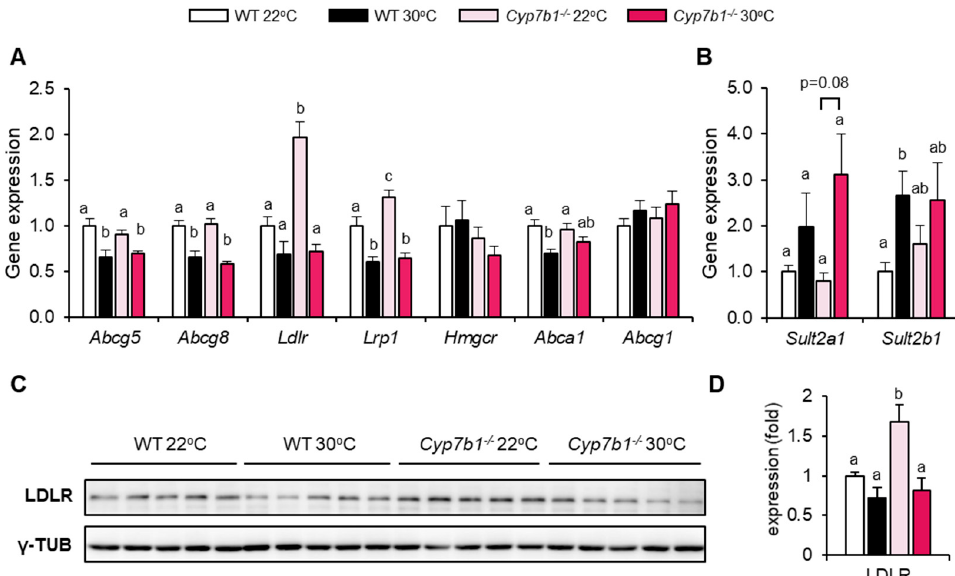
Figure 7. CYP7B1-deficiency affects expression of lipoprotein receptors but not other cholesterol-handling genes. Cyp7b1 − / − and WT littermates were housed at 22 °C or 30 °C and fed a CD-HFD for 8 months. ( A , B ) Relative hepatic expression of ( A ) lipoprotein receptors and cholesterol metabolism-related genes and (B) hepatic sulfotransferases (n = 8). ( C ) Western blot analysis and ( D ) quantification of hepatic LDLR. Gamma tubulin ( γ -TUB) was used as a loading control and for normalization. Data are shown as mean values ± SEM. Different letters indicate significant differences between groups ( p < 0.05) determined by two-way ANOVA.